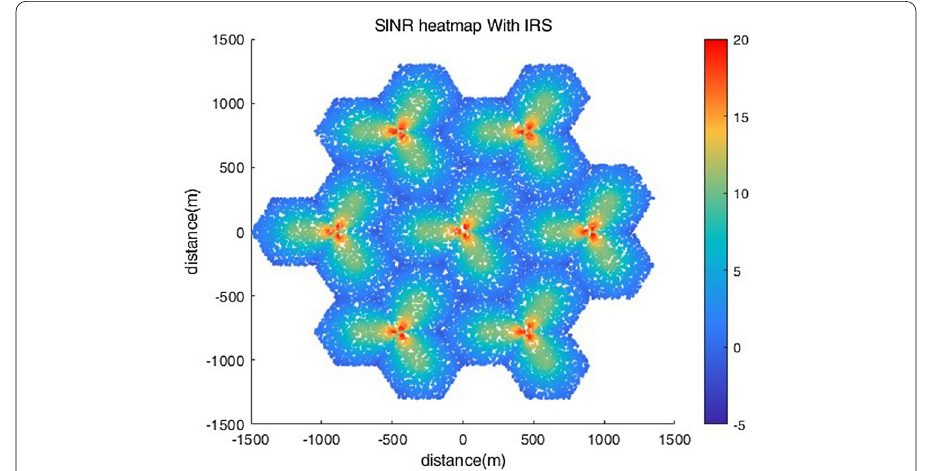
Fig. 8 SINR heatmap with IRS. From the figure, it can be seen that the received SINR of UE has increased